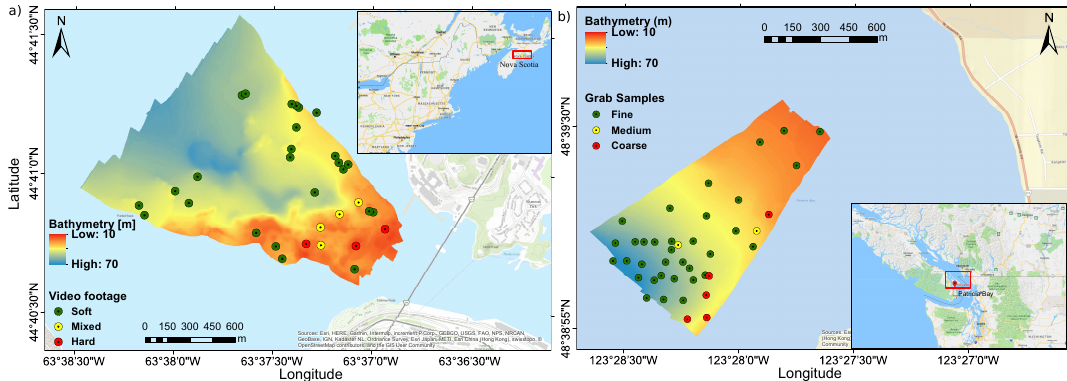
Figure 1. Bathymetry and location of the survey area ( a ) Bedford Basin, Canada, and ( b ) Patricia Bay, Canada. For both study areas the ground-truth locations and the corresponding classification are presented.